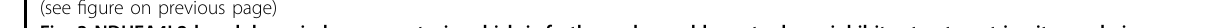
Fig. 3 NDUFA4L2 knockdown induces apoptosis, which is further enhanced by autophagy inhibitor treatment in vitro and vivo. A Apoptosis rates in LN229 and GBM-XX cells treated with chloroquine (CQ; 10 μ M) or Mdivi-1 (5 μ M) were determined by fl ow cytometry ( n = 3). B Protein levels of LC3, PARP, and cleaved-PARP in LN229 cells, following treatment with CQ (10 μ M), were determined by western blotting. C Protein levels of LC3, PINK1, Parkin, PARP, and cleaved-PARP in LN229 cells, following treatment with Mdivi-1 (5 μ M), were determined by western blotting. D – F Nude mice carrying tumors from LN229-transfected (sh-NDUFA4L2 or sh-NC by lentivirus) cells untreated or treated with Mdivi-1 (3 mg/kg) are shown ( n = 5). The average tumor weight for each group was calculated. Tumor growth curves were calculated for each week. G-H NDUFA4L2, Ki67, LC3, p62, and cleaved-PARP expression levels, as well as positive cell numbers, were determined by immunohistochemical staining; apoptosis was assessed by TUNEL assay. Scale bar = 50 μ m. Means ± SDs of triplicate experiments are plotted. * p < 0.05, ** p < 0.01, *** p <